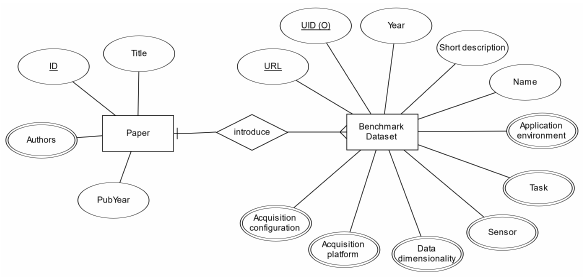
Figure 2. Entity-relationship model for metadata structure of benchmark